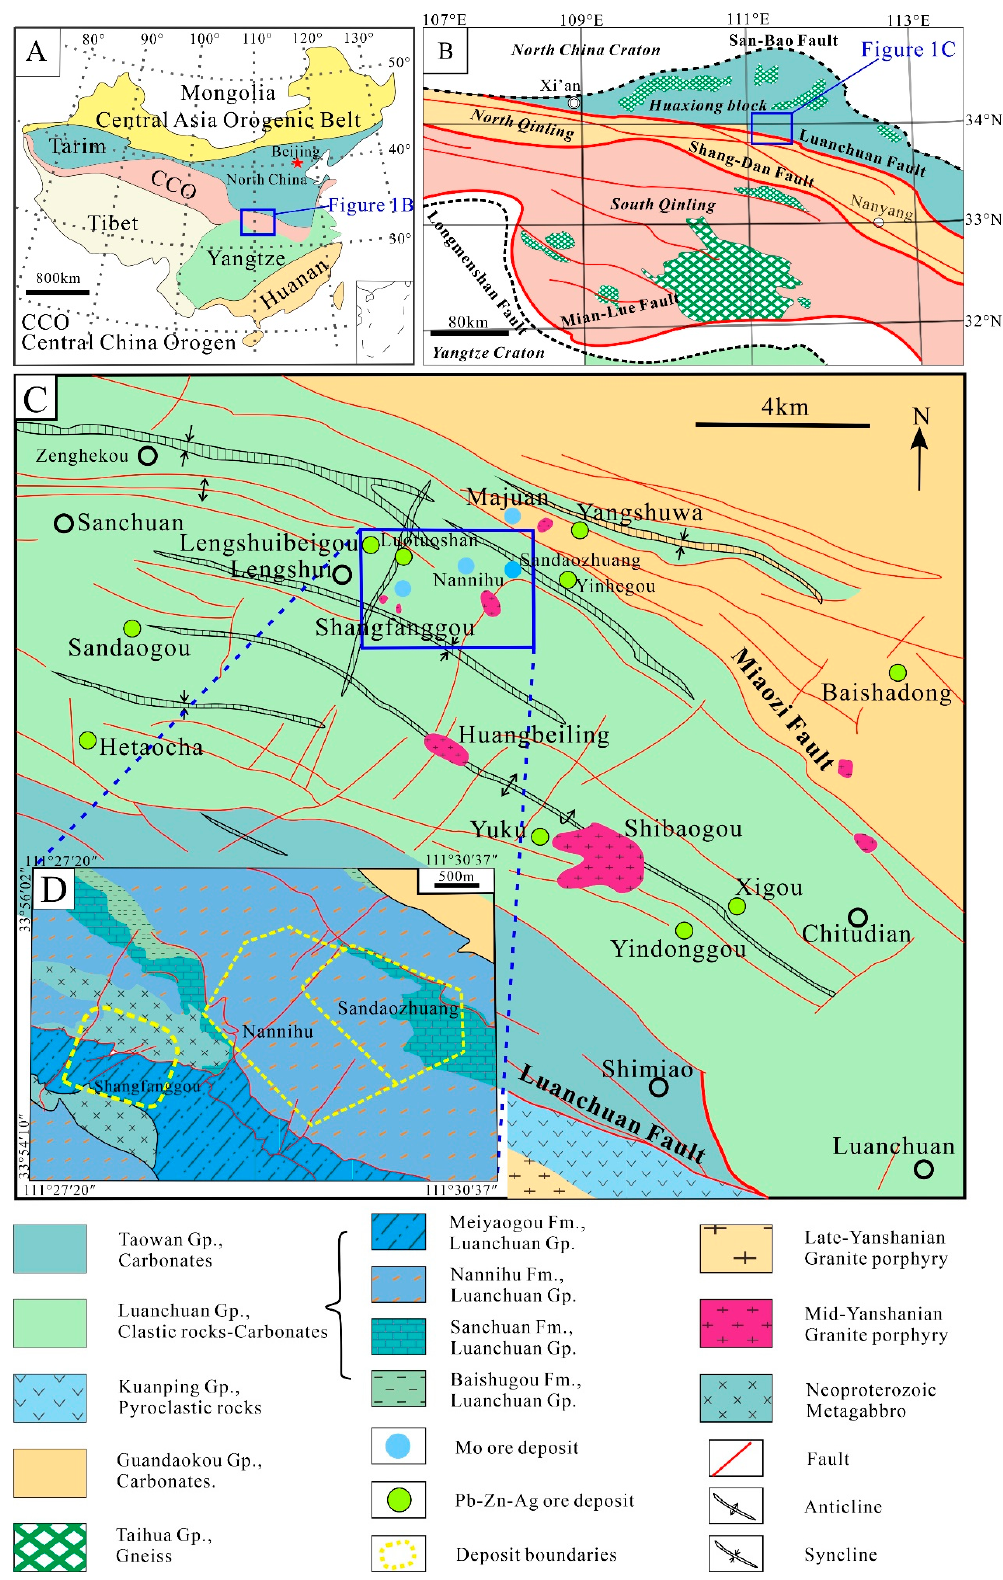
Figure 1. ( A ) Tectonic map of China, showing the location of the Qinling Orogen Belt; ( B ) tectonic subdivision of the Qinling Orogen Belt, showing the location of the Luanchuan ore district; ( C ) geological map of the Luanchuan ore district, showing the Shangfanggou Mo–Fe deposit (modified after [39]); ( D ) sketch of the Shangfanggou, Nannihu, and Sandaozhuang deposits (modified after